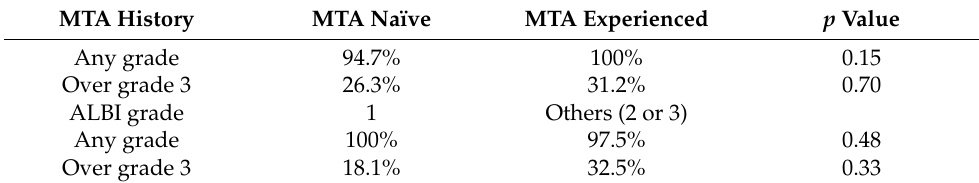
Table 3. The frequency of AE in difference of MTA history and